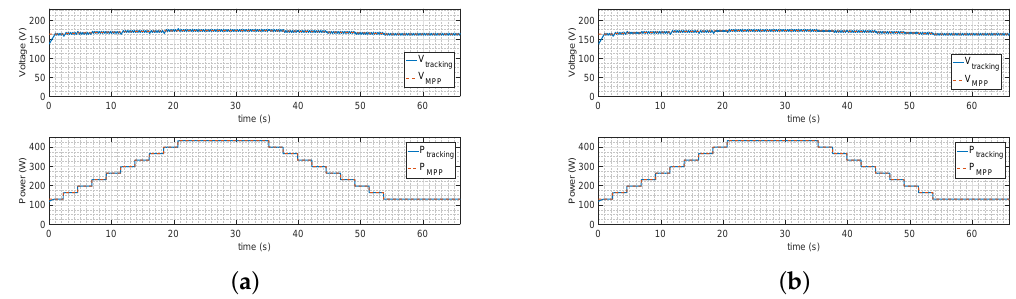
Figure 27. Dynamic test based on EN 50530:2010. ( a ) P & O ; ( b ) INC.